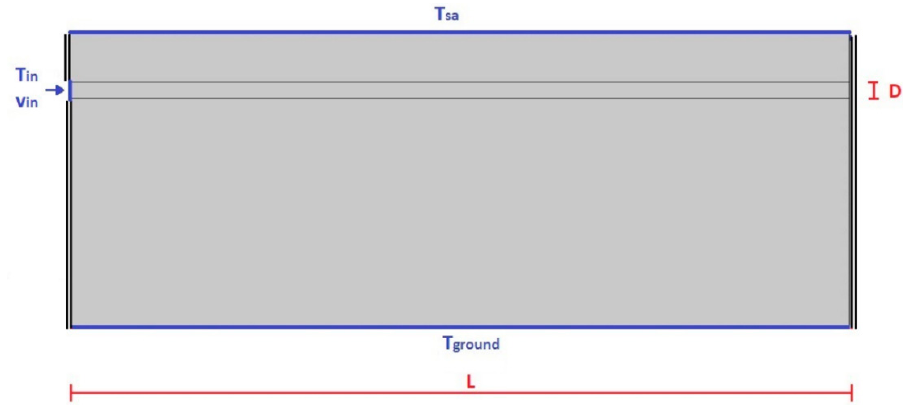
Figure 1. A schematic of the design of the numerical model of the horizontal Earth to Air Heat eXchanger (EAHX). eXchanger